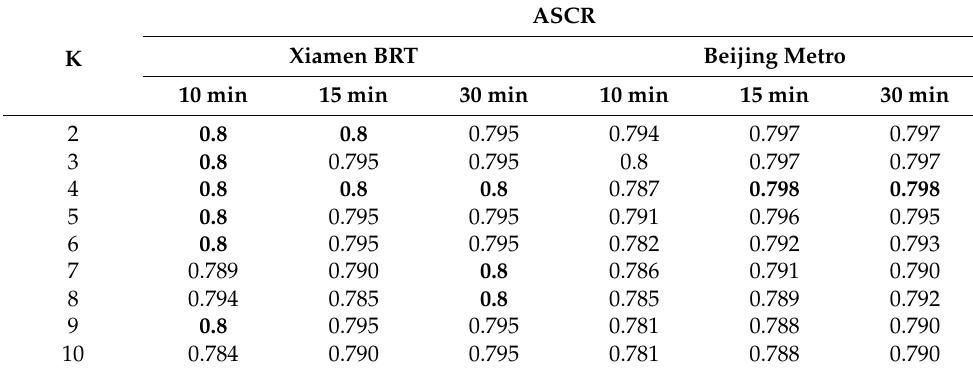
Table 4. ASCR with different K in the Xiamen BRT and the Beijing